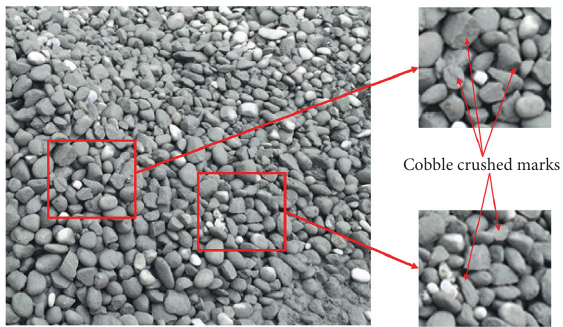
Figure 15: Cobbles discharged from EPB1 and